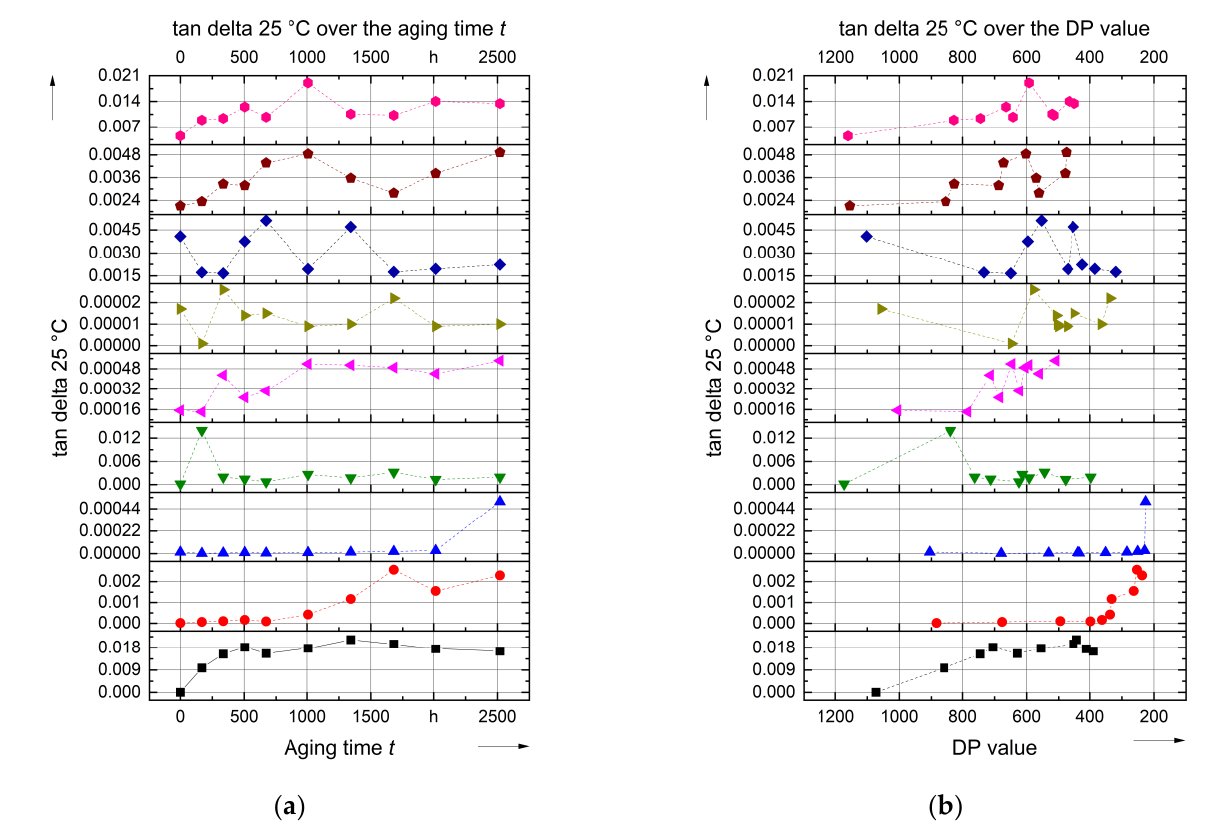
Figure 10. Change of dissipation factor tan δ at 25 °C for different sealing systems and fluids: ( a ) Change over the aging time; ( b ) Change over the DP value; the legends refer to Figure 6a.